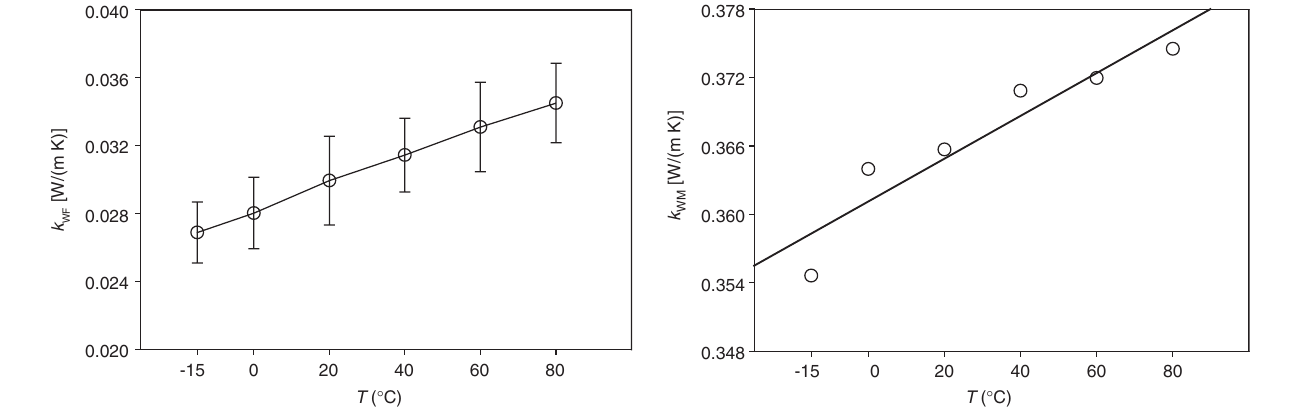
Figure 6 Thermal conductivity of the WF (mean values with 95% confidence intervals are reported).